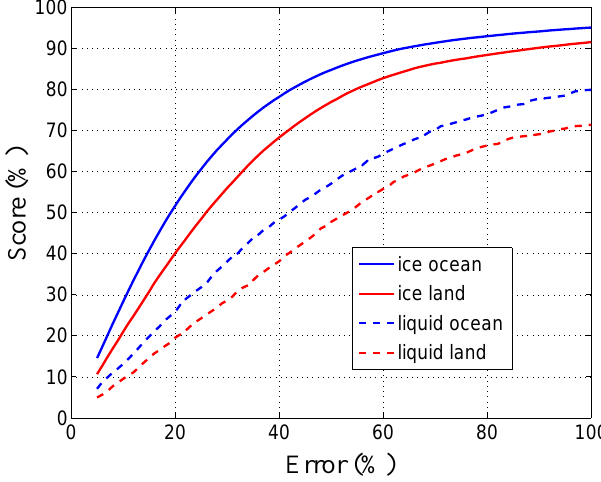
Fig. 14. Scores obtained in 2008 by the POLDER estimate of cloud vertical extent for liquid water (dashed line) and ice clouds (solid line) as a function of the retrieval error in percent. Scores corre- spond to a confidence in the retrieval for a given error. Scores are global (all classes of cloud geometrical thickness).